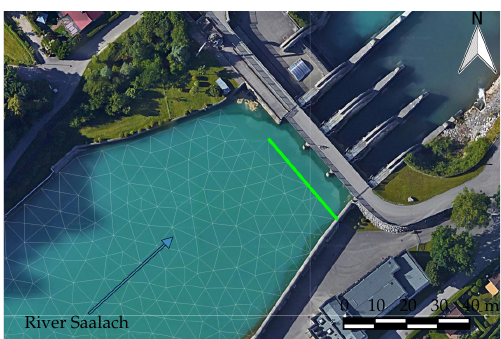
Figure 7. Computational grid close to the model outlet, highlighting the outflow boundary segments ( green ). Satellite image from